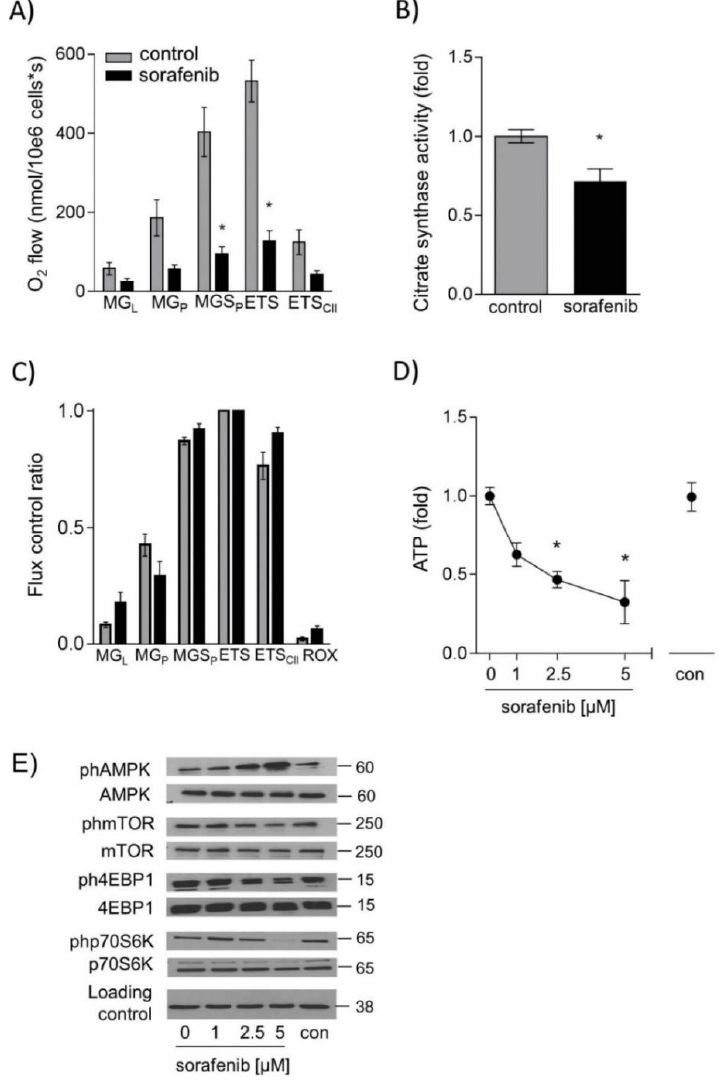
Figure 3. Sorafenib decreases respiration, adenosine triphosphate (ATP) levels and activation of